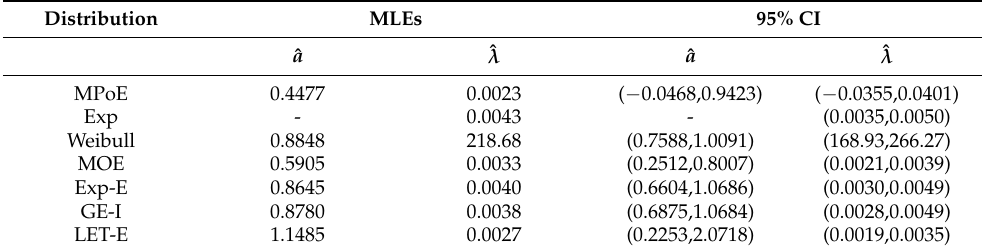
Table 9. Estimation results for coal mining data set.